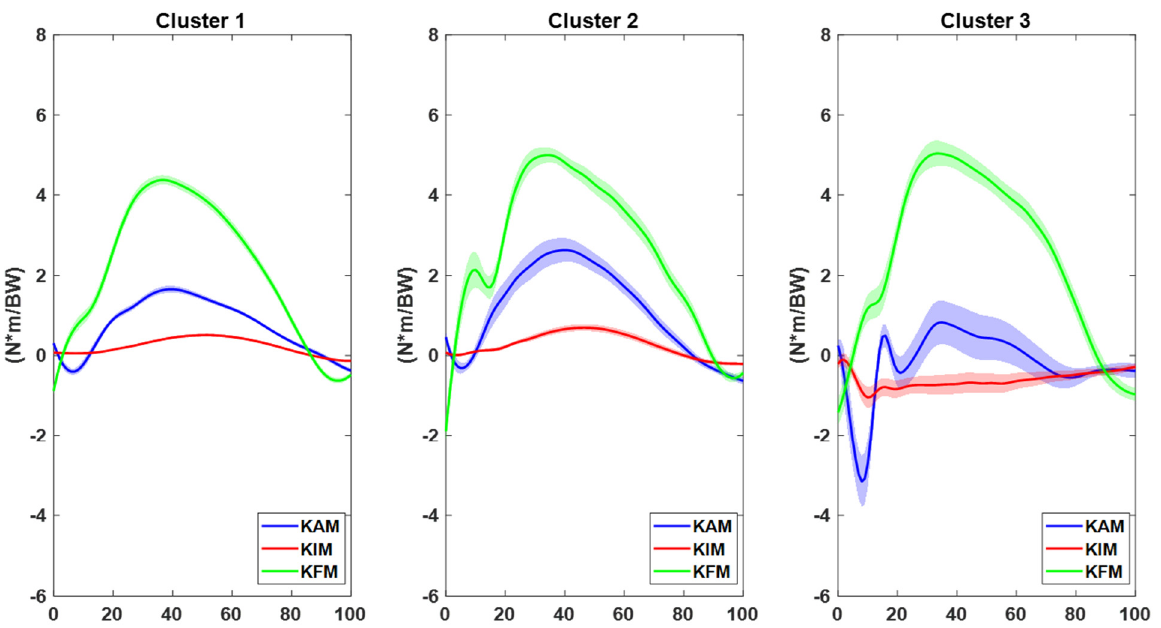
Figure 1. Knee kinetics clusters based on Haar wavelet collected in laboratory. Data are normalized over the stance phase of the change of direction and are presented as mean (solid lines) and standard deviation (shadow). Abbreviations: KAM = knee abduction moment (blue, negative: abduction); KIM = knee internal rotation moment (red, negative: external); KFM = knee flexion moment (green, negative: extension).